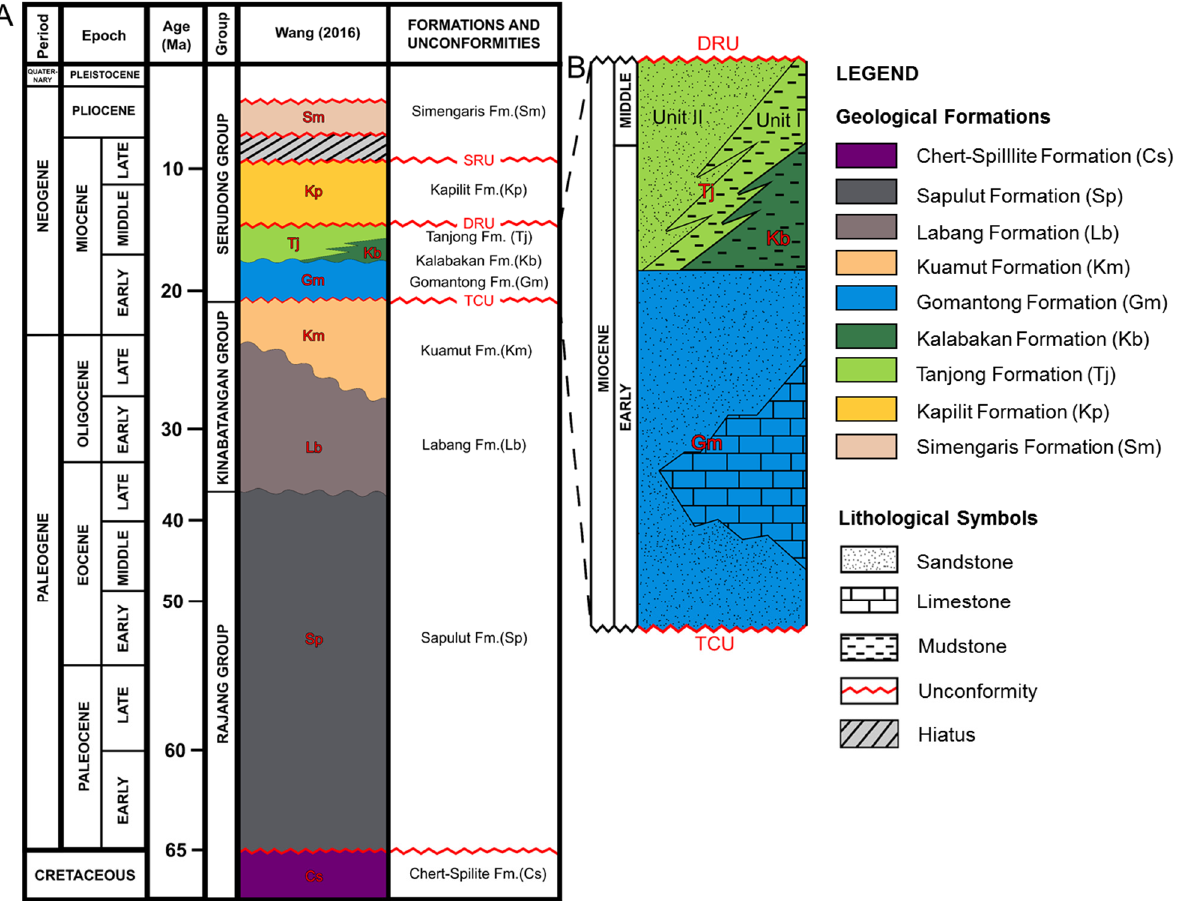
Figure 2. ( A ) General stratigraphic section of southern Sabah, modified from [1,29]. The red box indicates the studied rock formation. ( B ) Simplified stratigraphic framework for the onshore Early- Middle Miocene Gomantong, Kalabakan, and Tanjong Formation. Abbreviations: TCU—Top Croker Unconformity; DRU—Deep Regional Unconformity; SRU—Shallow Regional